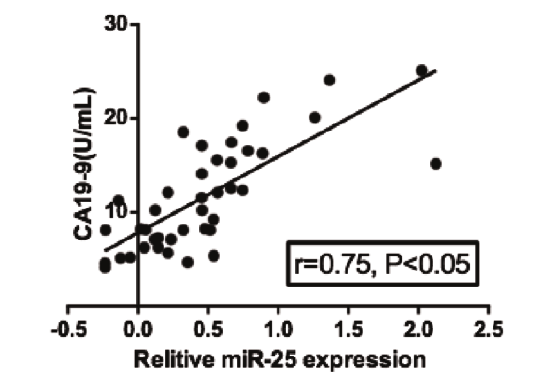
Figure 3: Scatter plot demonstrates the positive correlation between miR-25 expression and CA19-9 concentrations in serum of GC